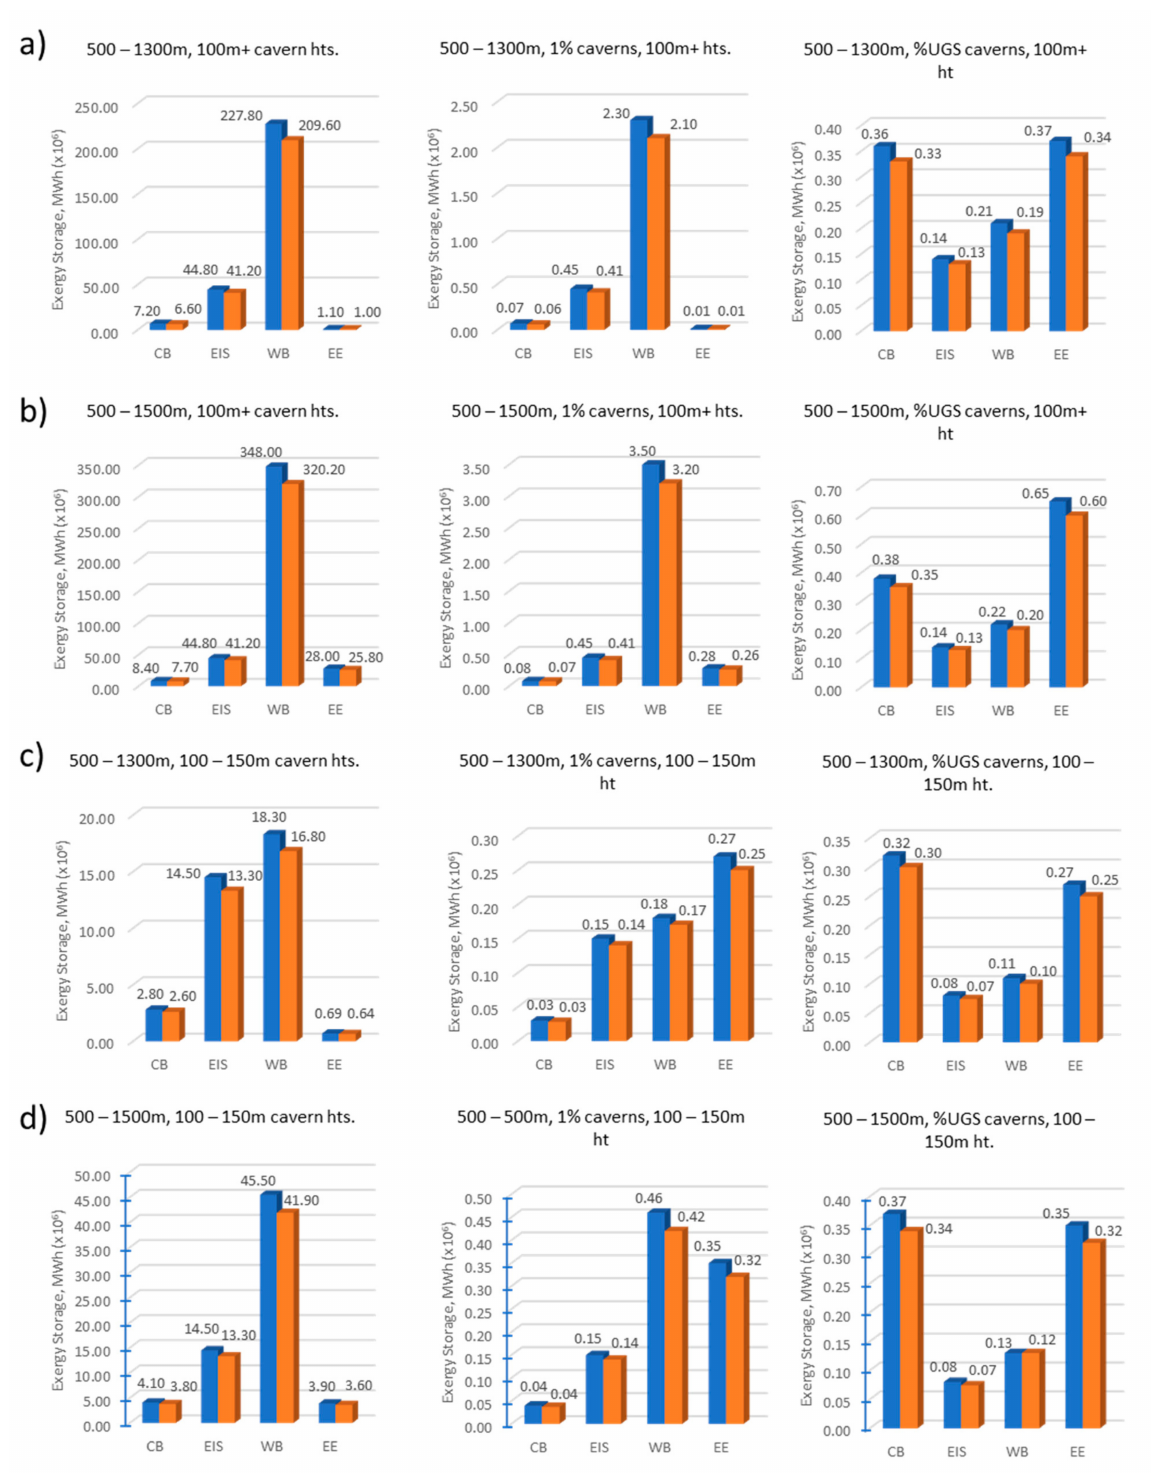
Figure 4. Plots of ‘static’ (one-fill) exergy storage estimates for the preferred CHT model, over the two depth ranges and cavern sizes (100 m+ and 100–150 m height) considered for CAES. Graphs for all potentially available caverns, 1% of available caverns and estimates based upon a percentage related to the number of UGS caverns in the basin. Parts ( a , c ) show data for the 500–1300 m depth range and parts ( b , d ) those data for the 500–1500 m depth range. Key common to all: blue = stored exergy, brown = stored exergy to